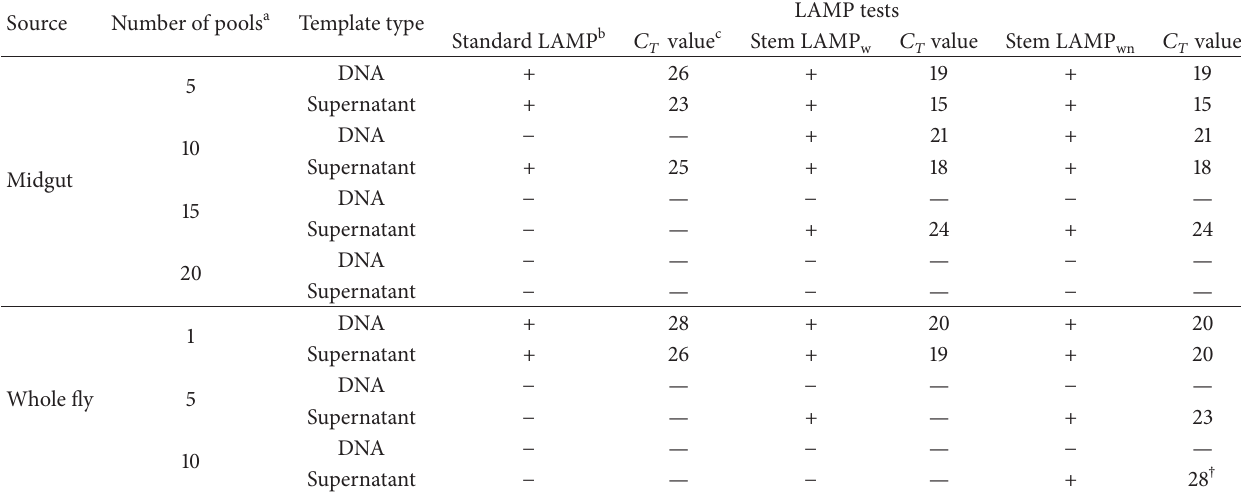
Table 1: The analysis of tsetse fly samples using T. brucei gambiense standard and stem LAMP test formats. Source